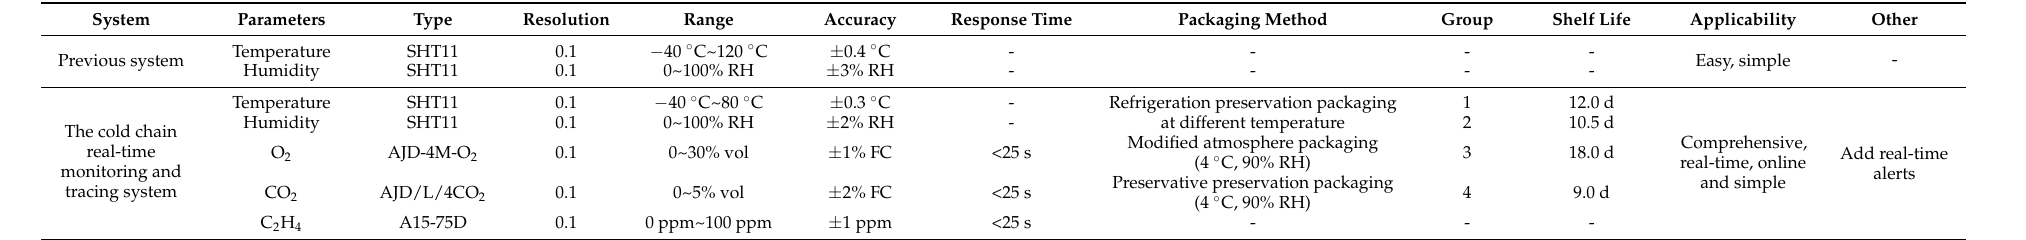
Table 2. System performance